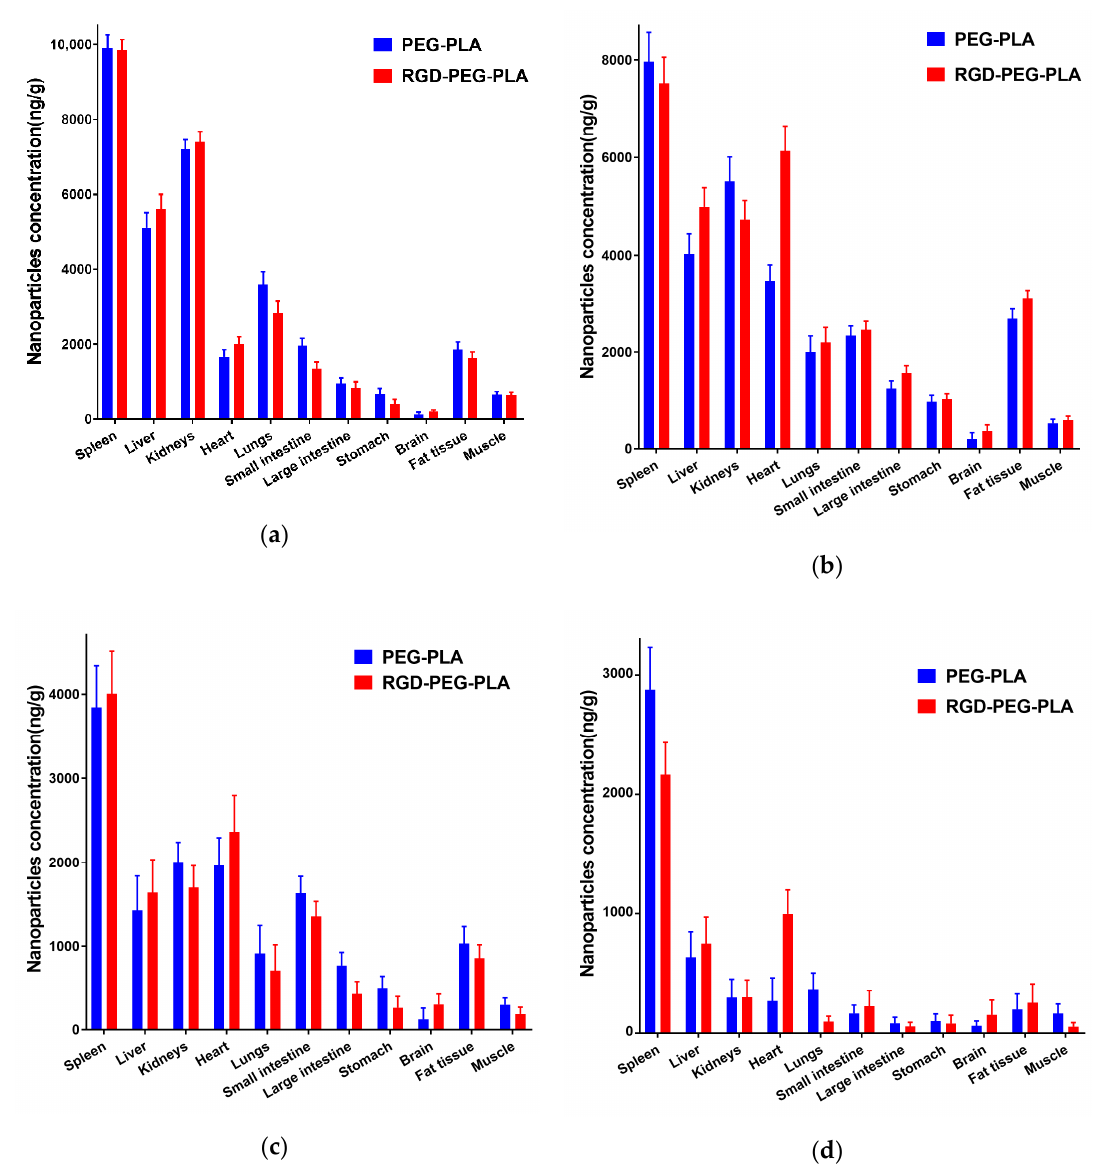
Figure 2. Concentration of nanoparticles in the spleen, liver, kidneys, heart, lungs, small intestine, large intestine, stomach, brain, fat tissue, and muscle after administration of PEG-PLA and RGD-PEG-PLA in rat models at ( a ) 0.5 h, ( b ) 4 h, ( c ) 12 h, ( d ) 36 h (mean ± standard deviation (SD), n = 6).